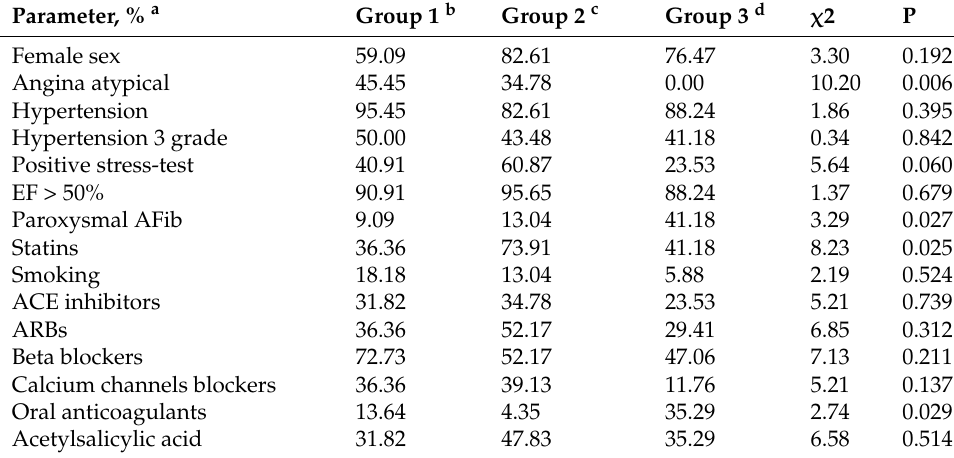
a ; EF—ejection fraction; AFib—atrial fibrillation; ACE—angiotensin-converting enzyme; ARBs—angiotensin receptor blockers. b Group 1—patients with predominant vulnerable atherosclerotic plaques; c Group 2—patients with predominant stable atherosclerotic plaques; d Group 3—patients with patent coronary arteries (plaque-free group).